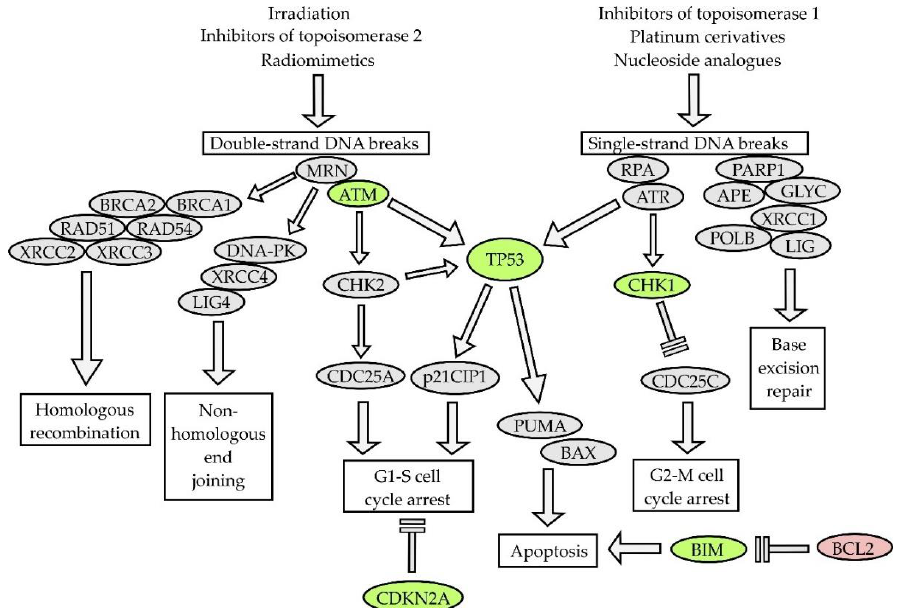
Figure 5. DNA damage response pathways. Double-strand DNA breaks: MRN—MRE11–RAD50–NBN (Nibrin) complex, ATM—ataxia-teleangiectasia mutated, BRCA1, BRCA2—breast-related cancer antigen 1, 2, XRCC2/3—X-ray repair cross complementing 2/3, DNA-PK—DNA protein-kinase, XRCC4—X-ray repair cross complementing 4, LIG4—DNA ligase 4, CHK2—check-point kinase 2, CDC25—cell division cycle 25; Single-strand DNA breaks: RPA—replication protein A, ATR—ataxia teleangiectasia and RAD3 related, CHK1—check-point kinase 1, CDC25C—cell division